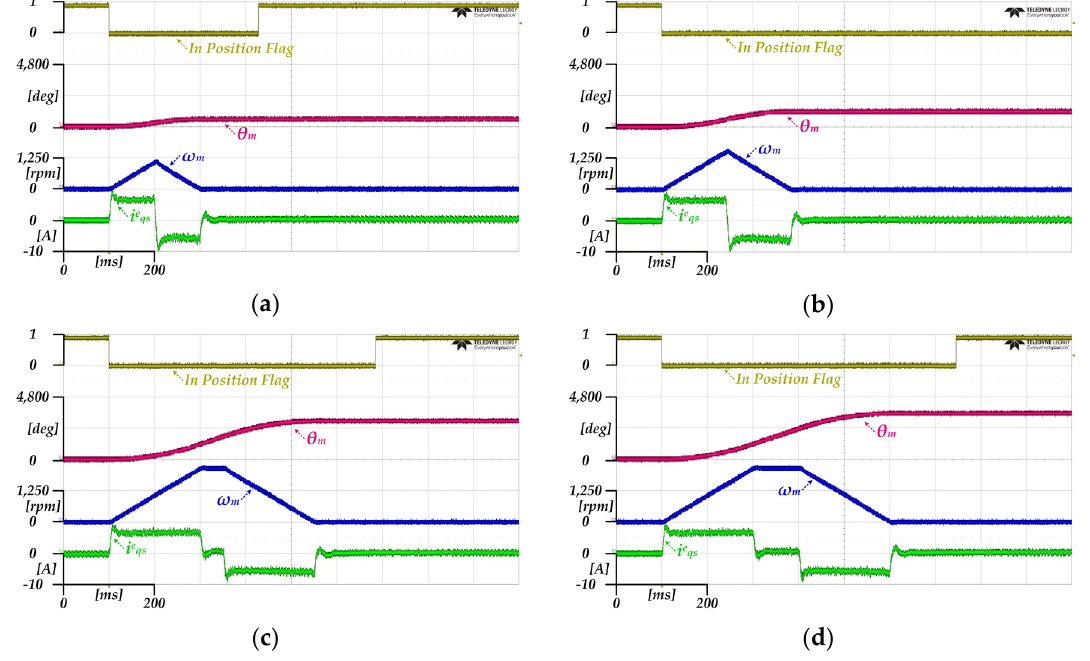
Figure 8. Position, velocity and q-axis current of the conventional time-based profile generator ( a ) ( a ) 600 [deg] position reference; ( b ) 1200 [deg] position reference; ( c ) 3000 [deg] position 600[deg] position reference; ( b ) 1200[deg] position reference; ( c ) 3000[deg] position reference; ( d ) 3600[deg] position reference.